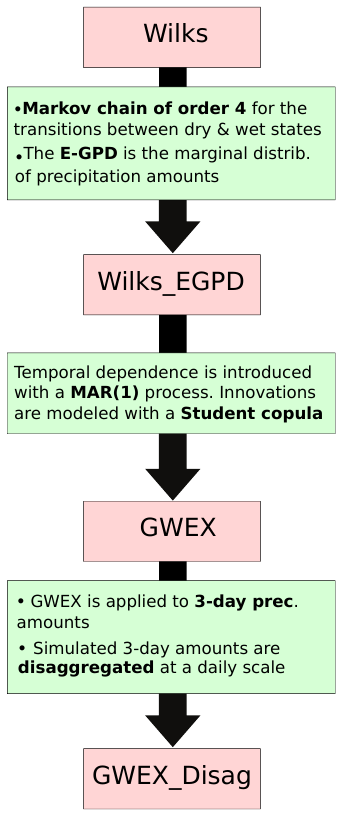
Figure 3. Flowchart of the different model versions. The differences between the models are summarized inside green